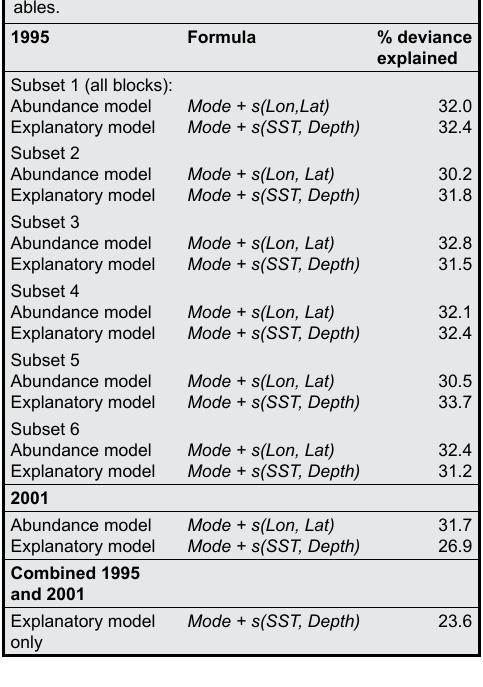
Fig. 8. Estimated whale density for NASS- 2001. Density estimates are on a scale 0 to 0.05 whales/km² (see bar).